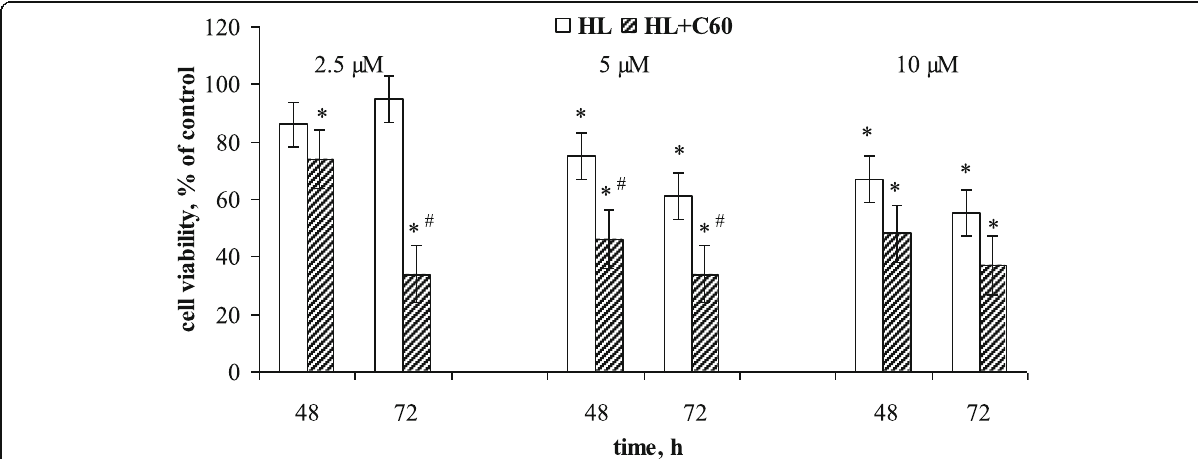
Fig. 6 Viability of CCRF-CEM cells incubated with diphenyl-N-(trichloroacetyl)-amidophosphate (HL) alone or in combination with 16 μ M C 60